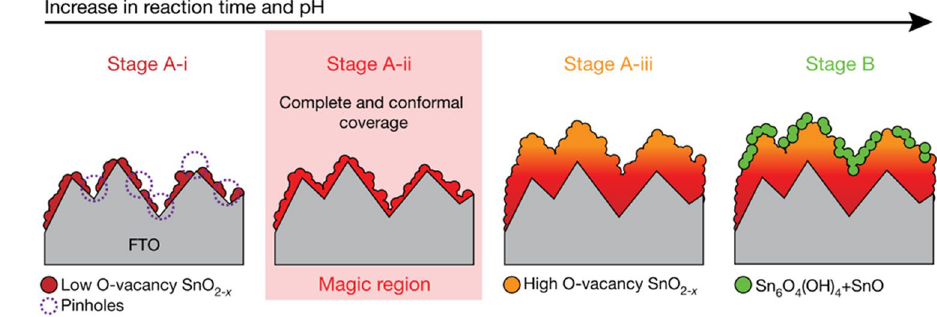
Fig. 3 Schematic illustration of four major stages at different reaction time and pH value of the chemical bath deposition for SnO 2 , the magic region highlights the A-ii stage that exhibits an ideal film coverage, morphology and chemical composition of SnO 2 film. Reproduced with per- mission from Ref. [39] Copyright 2021 Nature Publishing